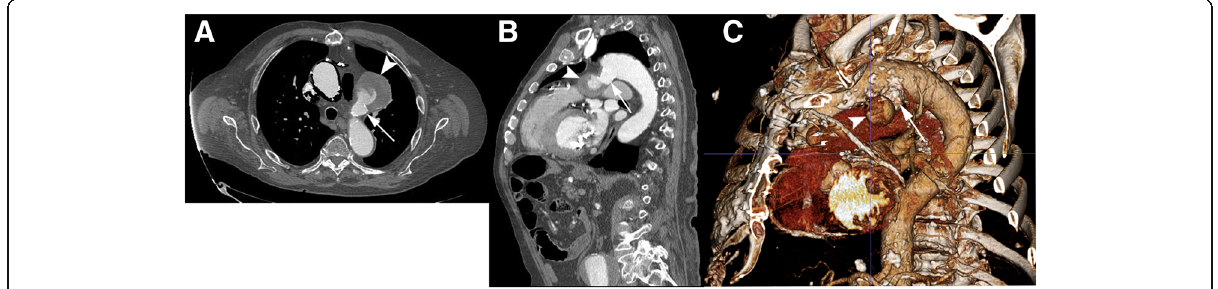
Fig. 1 Contrast-enhanced CTA of the thoracic aorta showing the ductus arteriosus diverticulum (DAD) (arrow) and pseudoaneurysm (arrowhead) a Axial image demonstrates junction of DAD and pseudoaneurysm b Two-dimensional reformatted sagittal plane image delineates the relationship between the aorta, the DAD, and the pseudoaneurysm. c Three-dimensional reconstruction of thoracic aorta for visualization and surgical